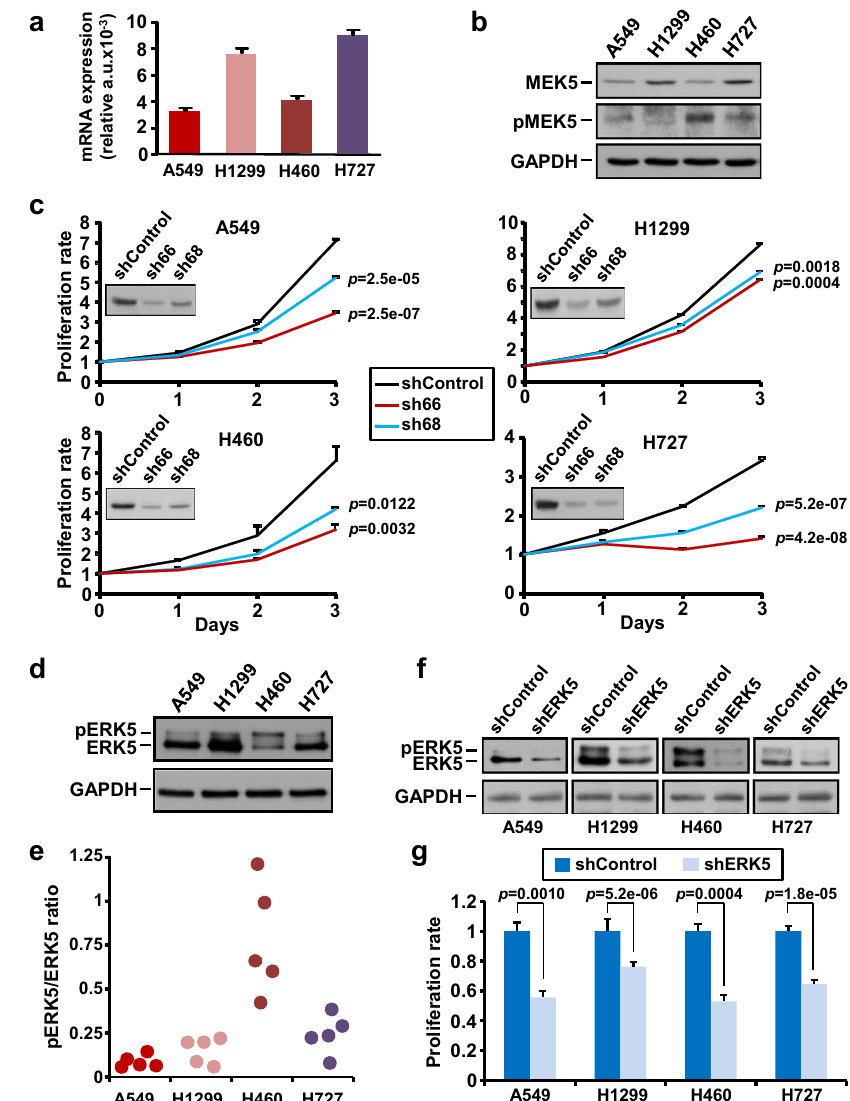
Fig. 2 Effect of the MEK5/ERK5 knockdown on cell proliferation of lung cancer cells. a MEK5 mRNA expression was determined by quantitative RT-PCR in NSCLC cell lines. GAPDH was used as control for differences in cDNA input. Data show the mean expression ± SD of an experiment that was repeated twice, calculated according to the ΔΔ C t relative quantitation method. b Expression of MEK5 and pMEK5 in NSCLC cell lines. 50 µg of whole-cell lysates were used to detect MEK5 by western blotting. For pMEK5 detection, 2 mg of protein were immunoprecipitated with the anti-MEK5 antibody followed by western blotting with the anti-pMEK5 antibody. GAPDH was used as loading control. c Effect of MEK5 knockdown on cell proliferation. Knockdown of MEK5 was carried out by lentiviral infection of NSCLC cells with a scrambled control sequence or MEK5 speci fi c shRNAs (sh66 and sh68) and levels of MEK5 were evaluated by western blotting. The effect of MEK5 knockdown on cell proliferation was measured by MTT assay at the indicated times. Data are presented as the mean ± SD of an experiment that was repeated three times. p -values were calculated according to a two-sided Student ’ s t -test. d Expression of total ERK5 in NSCLC cell lines. pERK5 and total ERK5 were evaluated by immunoprecipitating 1 mg of protein with the anti-ERK5 antibody and blots probed with the C-terminal anti-ERK5 antibody. GAPDH was used as loading control. e pERK5 quantitation in NSCLC cells. pERK5 (upper band) and ERK5 (lower band) levels from fi ve independent western blot studies were quanti fi ed with the ImageJ software and the pERK5/ERK5 ratio represented. f Silencing of ERK5 in NSCLC cells by shRNA was con fi rmed by western blotting with the anti-ERK5 antibody. GAPDH was used as loading control. g Proliferation effect of ERK5 knockdown was evaluated at 3 days as in ( c